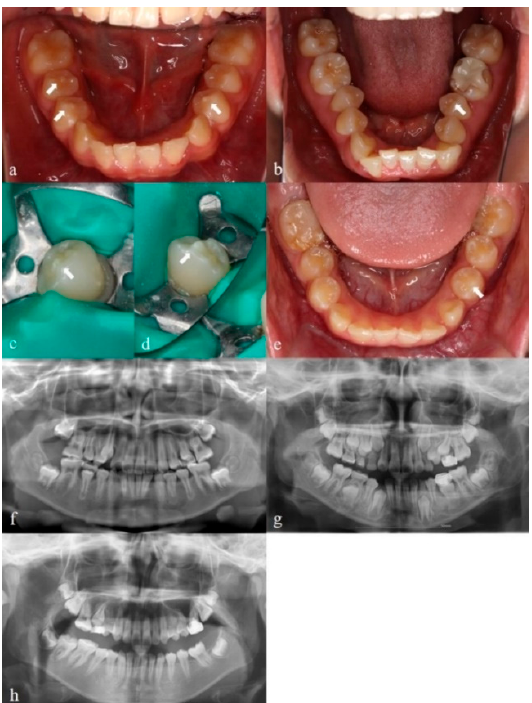
Figure 2. Intraoral radiographs of Patients ( a ) A-1, ( b ) A-2, ( c , d ) B-1, and ( e ) B-2. Panoramic radiographs of Patients ( f ) A-1, ( g ) B-1, and ( h ) B-2. White arrows denote DE.